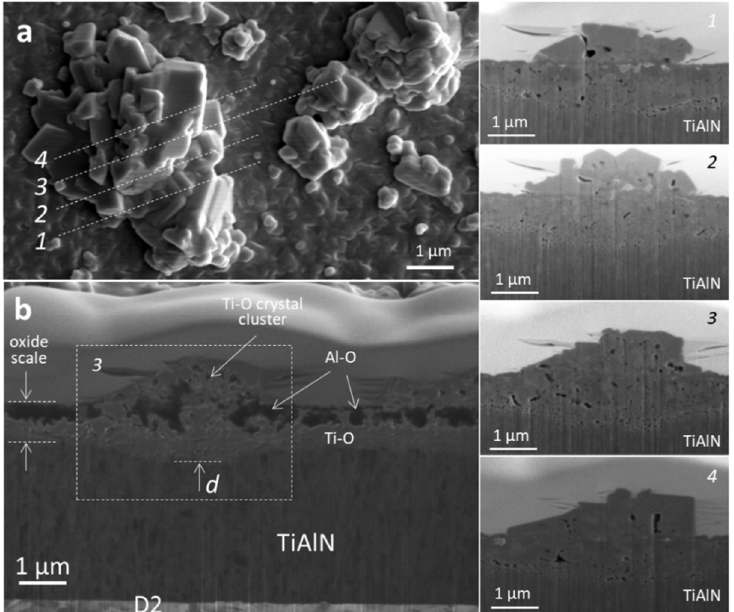
Figure 12. Top-view SEM image of the TiAlN coating surface after oxidation at 850 ◦ C for 60 min ( a ); SEM images of FIB cross-sections through larger cluster of TiO 2 crystals in direction marked with dashed lines 1, 2, 3, and 4; ( b ) ion-generated SEM image of FIB cross-section in direction marked with dashed line